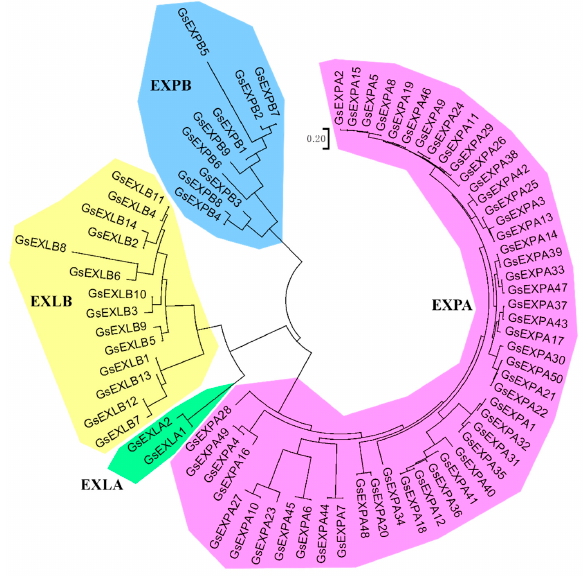
Figure 1. Amino acid phylogenetic tree of wild soybean expansin family members.